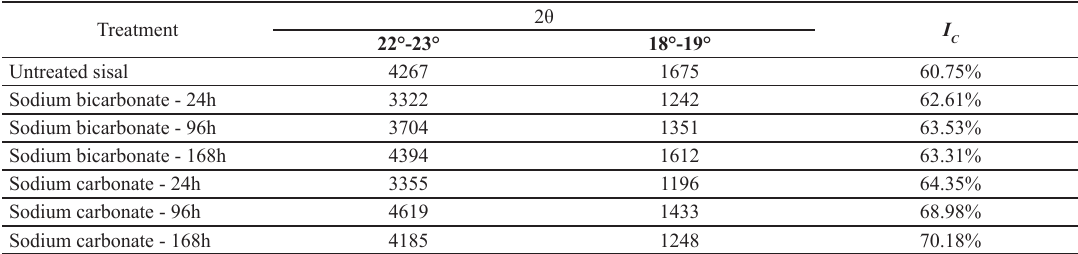
(Figure 10e to g) compared to NaHCO for all treatment 3 times, indicating a partial removal of hemicellulose and waxes from the fibre surface. A greater amount of OH - ions, released by the Na CO solution (see Table 2), leads to greater 2 3 removal of the wax layer and hemicellulose, affecting the surface wettability and mechanical properties of the resulting composite laminates 13 .